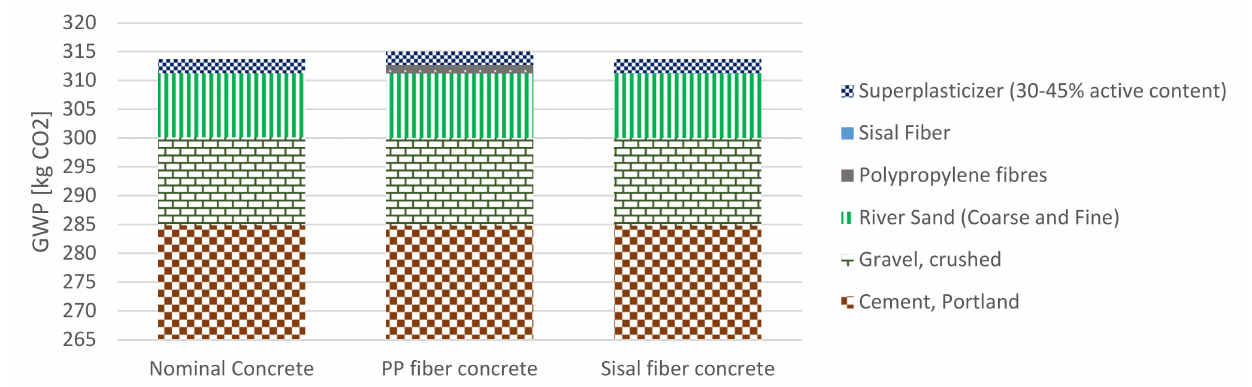
Figure 9. Process contribution for 1 m 3 of the concrete mixes.